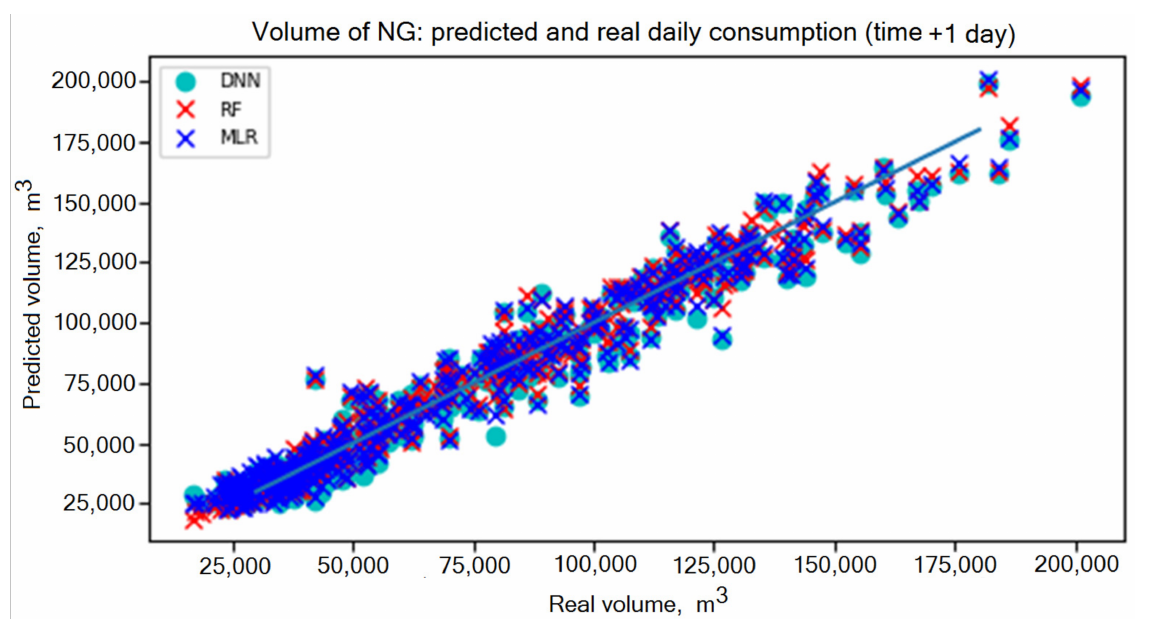
Figure 9. Actual and predicted consumption of natural gas for metering station (day ahead). The accuracy of predicting the daily demand for natural gas performed by the MLR, RF, and DNN algorithms is shown in Figure 10, which presents 200 random values predicted by MLR, RF, and DNN and the actual values (solid blue line). It shows that in the majority of cases, the curves coincide, and in those points where there is no convergence between them.